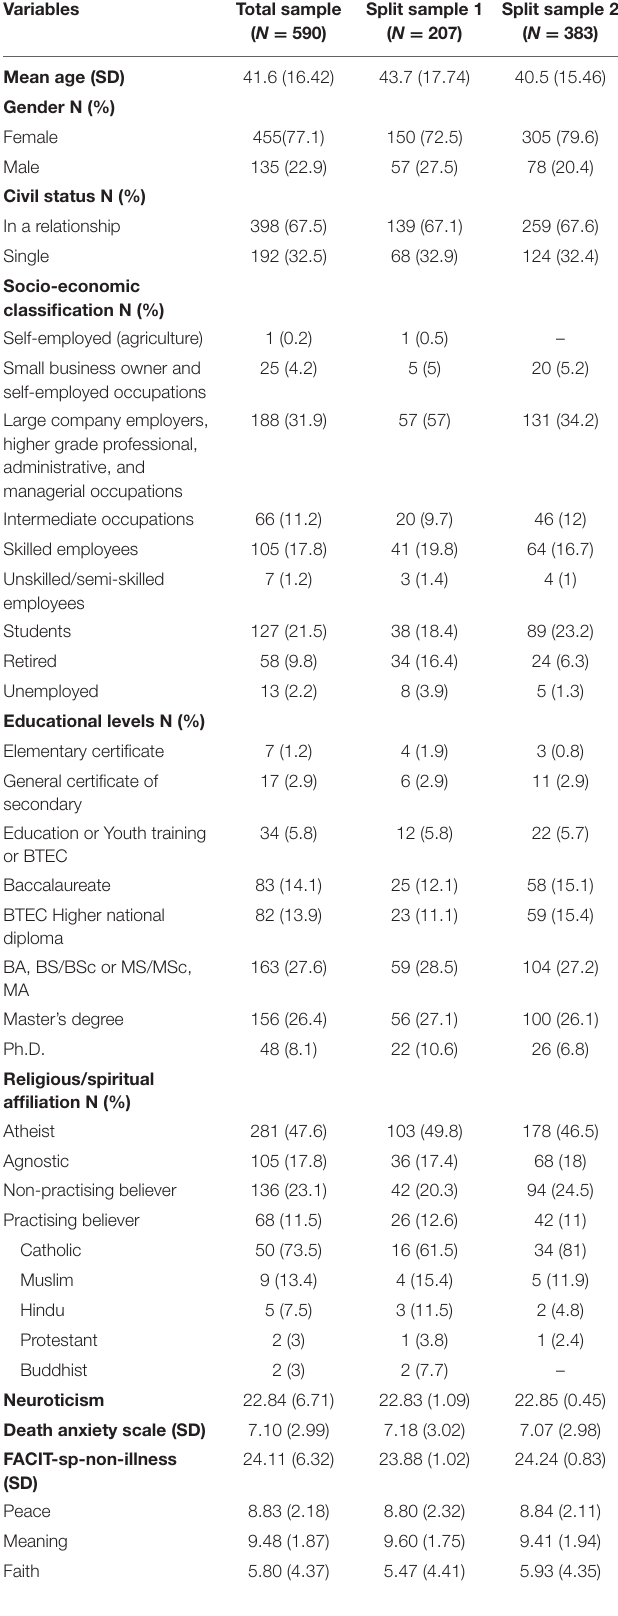
TABLE 1 | Descriptive statistics of the demographic characteristics of